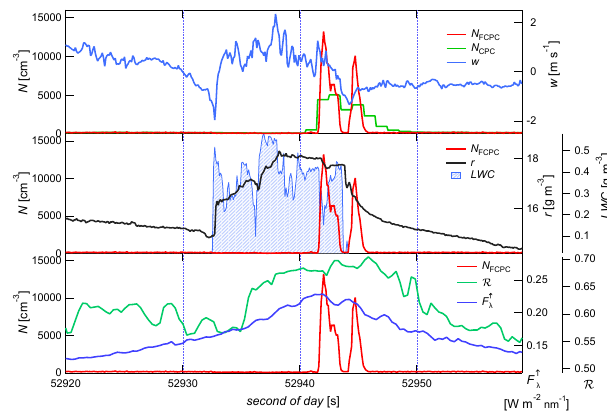
Figure 7. Section of the measurement flight on 22 April 2011; same variables as in Fig. 6. Figure 8. Section of the measurement flight on 23 April 2011; same variables as in Fig.